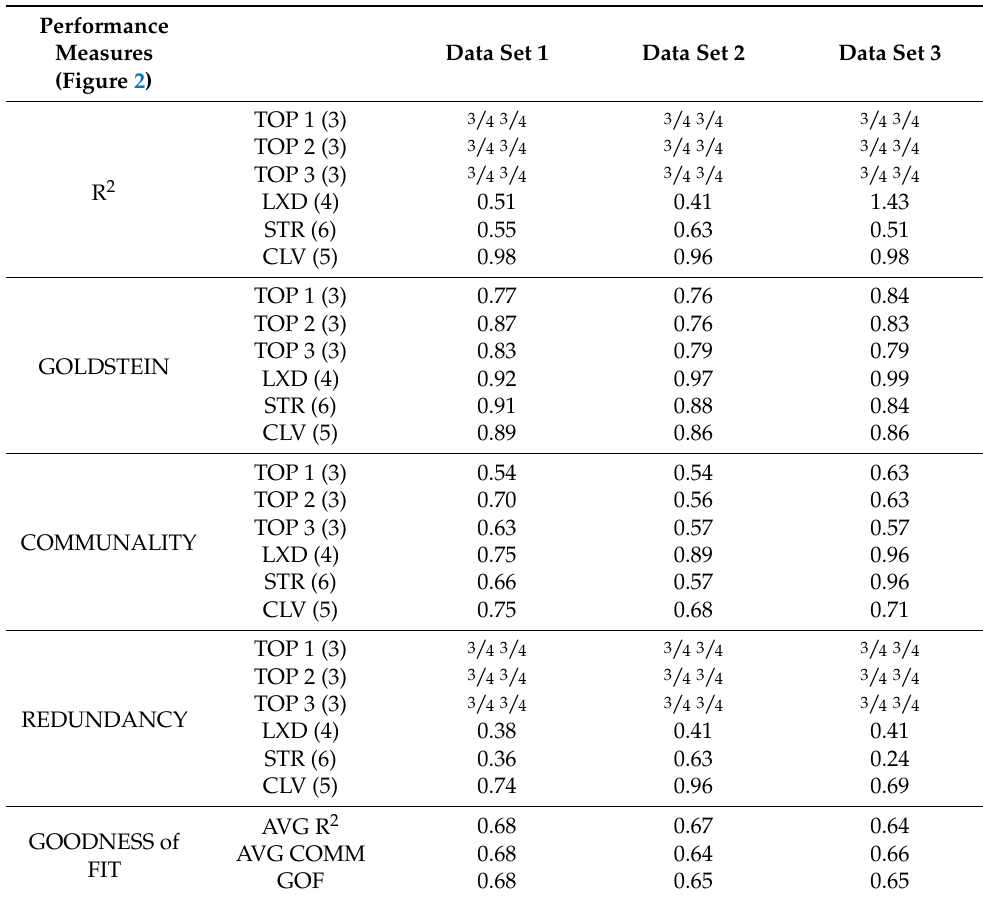
Table 5. Model estimation; performance measures (Sarstedt et al., 2019) [44]. The number of indicators for each latent variable is mentioned in the second column in between parentheses. In this table “ 3 / 4 3 / 4 ” means missing value.